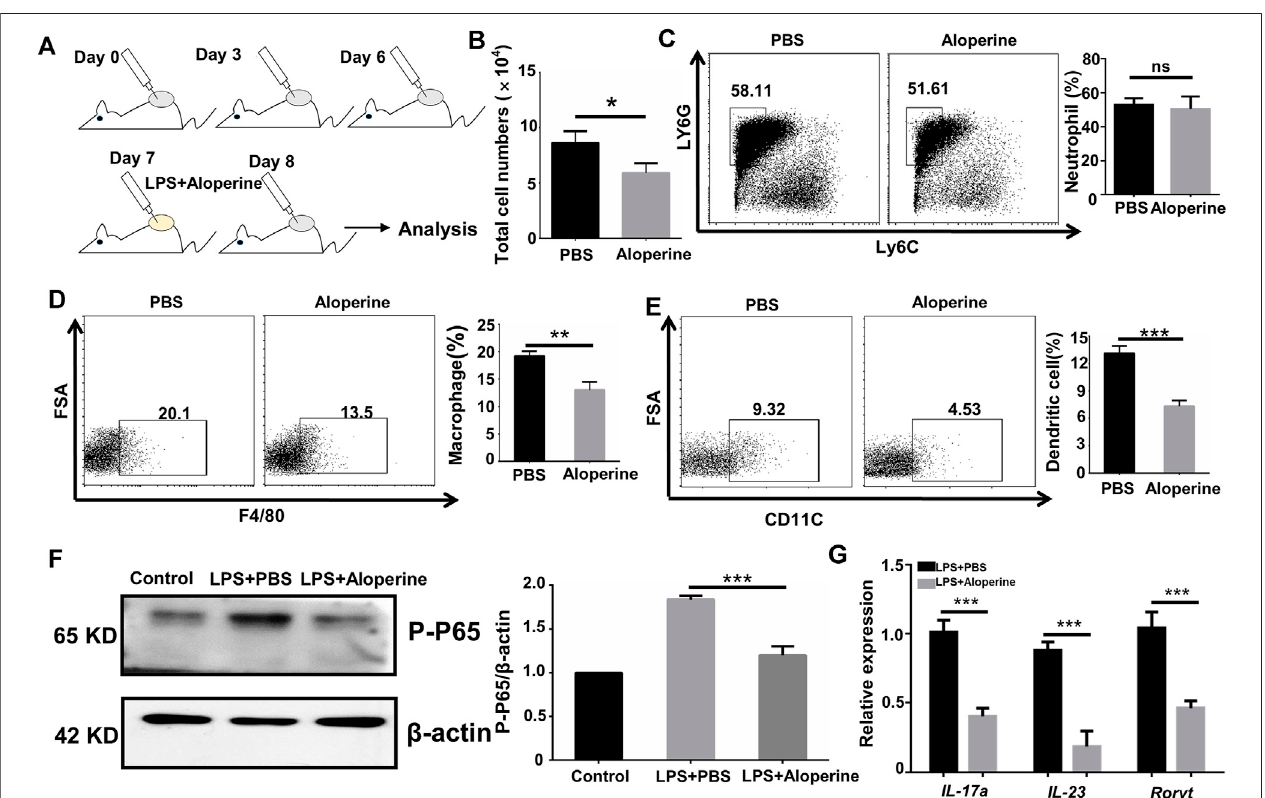
FIGURE3| Aloperineinhibits the migration and Th17-inducingeffect ofDCs. (A) Agraphicalpresentation oftheair pouchmodel. On the fi rst day,3 mlofsterile air wasinjected subcutaneouslyintoashaved skin siteon theback ofeach mice.Then, thepouches weresettled for3 days tohealthewound. On thethirdday, thisaction was repeated. On the sixth day, LPS was injected into the pouches with or without aloperine. The exudates were collected for subsequent analysis 24 h later. (B) Quantitative analysis of total cell numbers in the skin. (C – E) Representative fl ow cytometry analysis of neutrophils (CD11b + MHC-II − Ly6G + Ly6C − ), macrophages (CD11b + F4/80 + ), and DCs (CD11c + F4/80 − ). (F) Western-blot analysis for p-P65 and β -actin. (G) Real-time PCR analysis of IL-17A, IL-23, and ROR γ t in CD4 + T-cells receiving DC cultural supernatant pretreated by LPS + PBS or LPS + aloperine. The values are presented as the mean ± SEM ( n = 5 mice per group). p p < 0.05; pp p < 0.01; and ppp p <